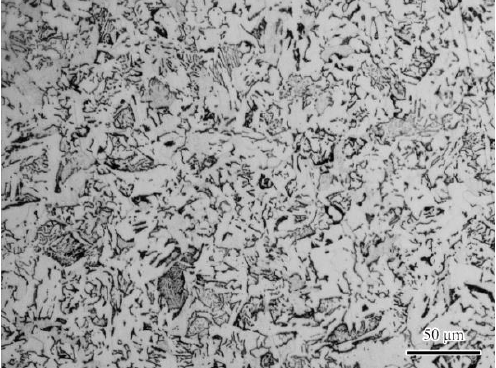
Figure 1. Optical microstructure of API X80 steel used in this work.